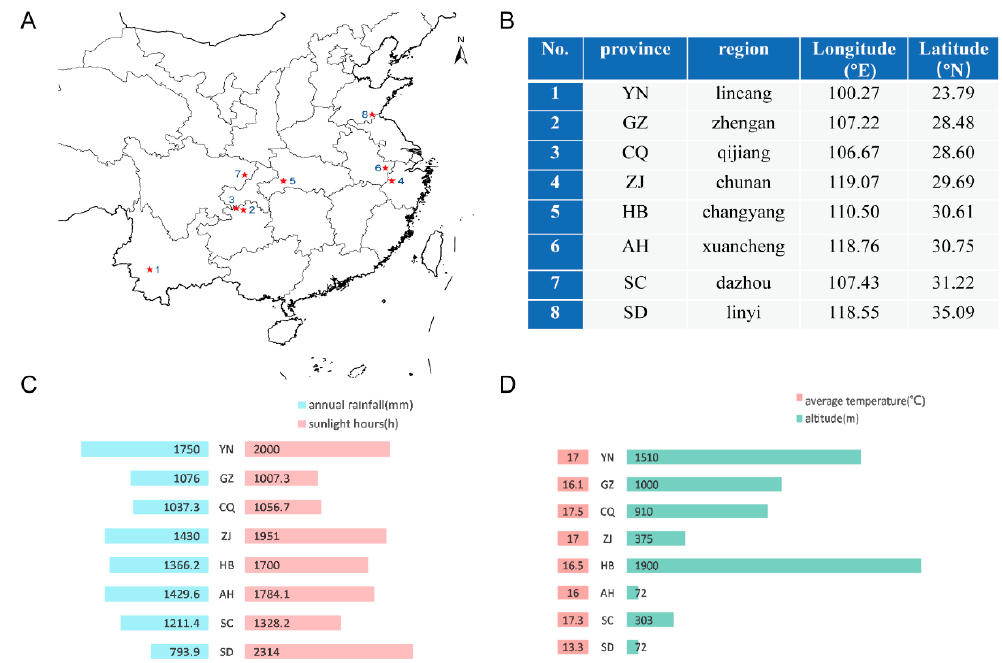
Figure 1. Geographical distribution and climatic conditions of C. speciosa samples collected. ( A ) Place of sample production. ( B ) Eight regional coordinates. ( C ) Annual rainfall (mm) and annual sunshine time (h). ( D ) Average yearly temperature (°C) and altitude (m). Climatic data were collected from